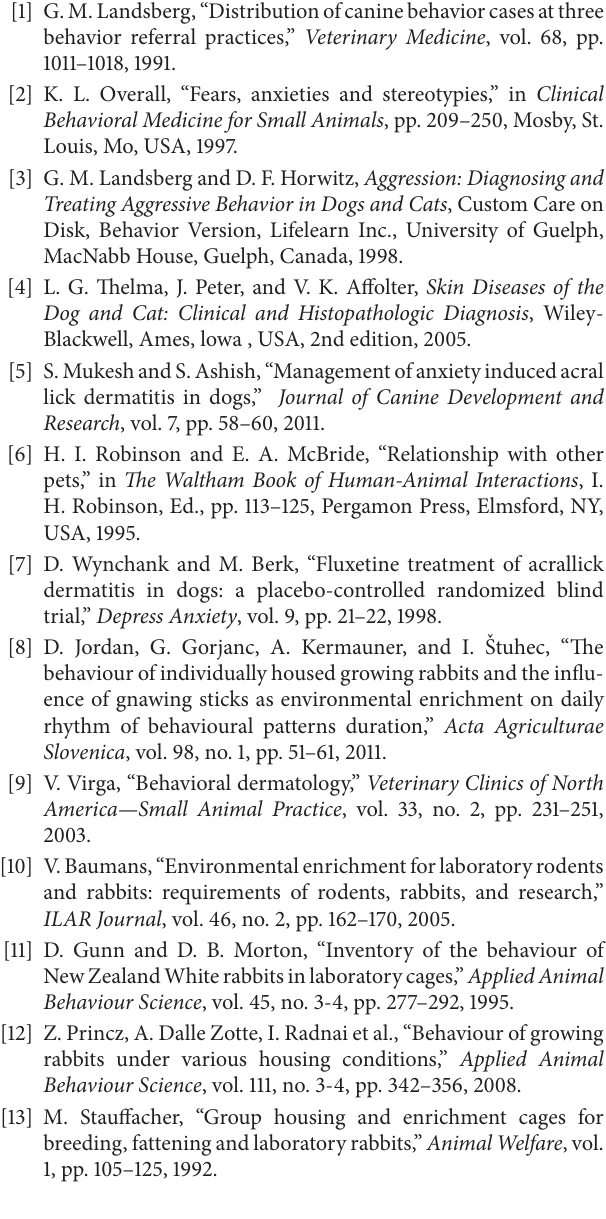
Figure 1: Rabbit with the sign of acral lick dermatitis.